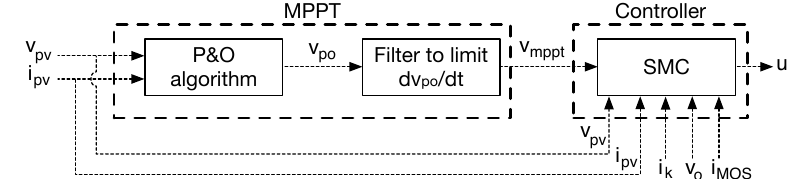
Figure 3. Block diagram of the MPPT